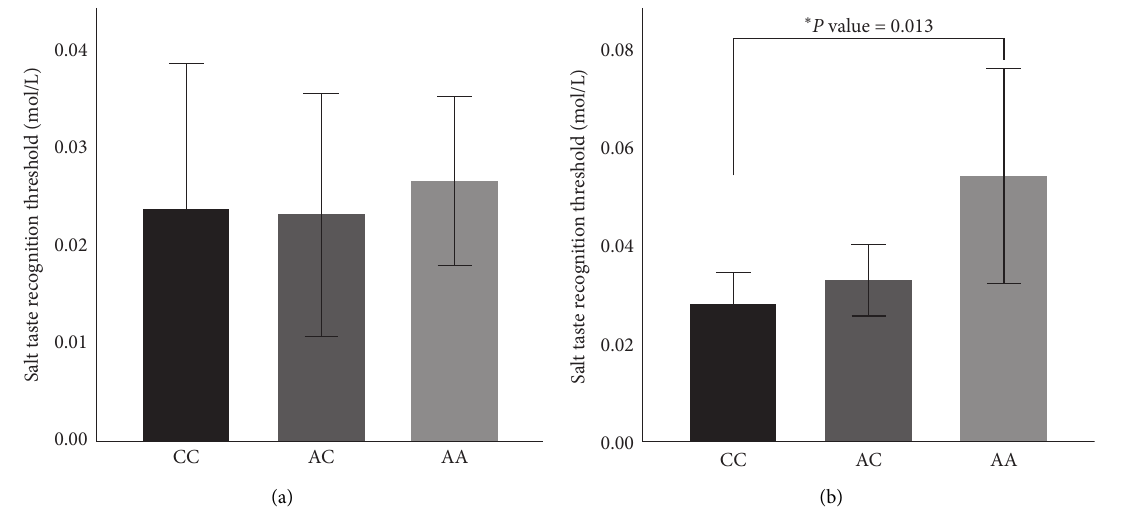
Figure 1: Salt taste recognition thresholds adjusted for BMI status and TRPV1 genotypes for rs4790522 within the hypertensive group. Statistical differences were determined using One-way ANOVA, ∗ post hoc test ( P value < 0.05). (a) Salt taste recognition threshold and TRPV 1 genotype for rs4790522 in normal weight group. (b) Salt taste recognition threshold and TRPV 1 genotype for rs4790522 in overweight/obese group.